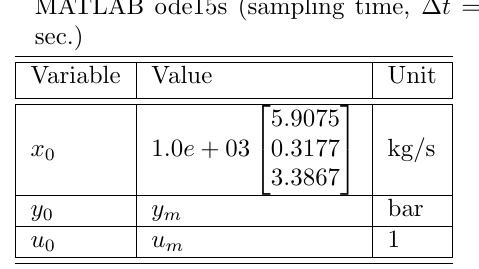
Table 5: Initial values for the simulations on Di Meglio model. The ODE is solved each timestep with